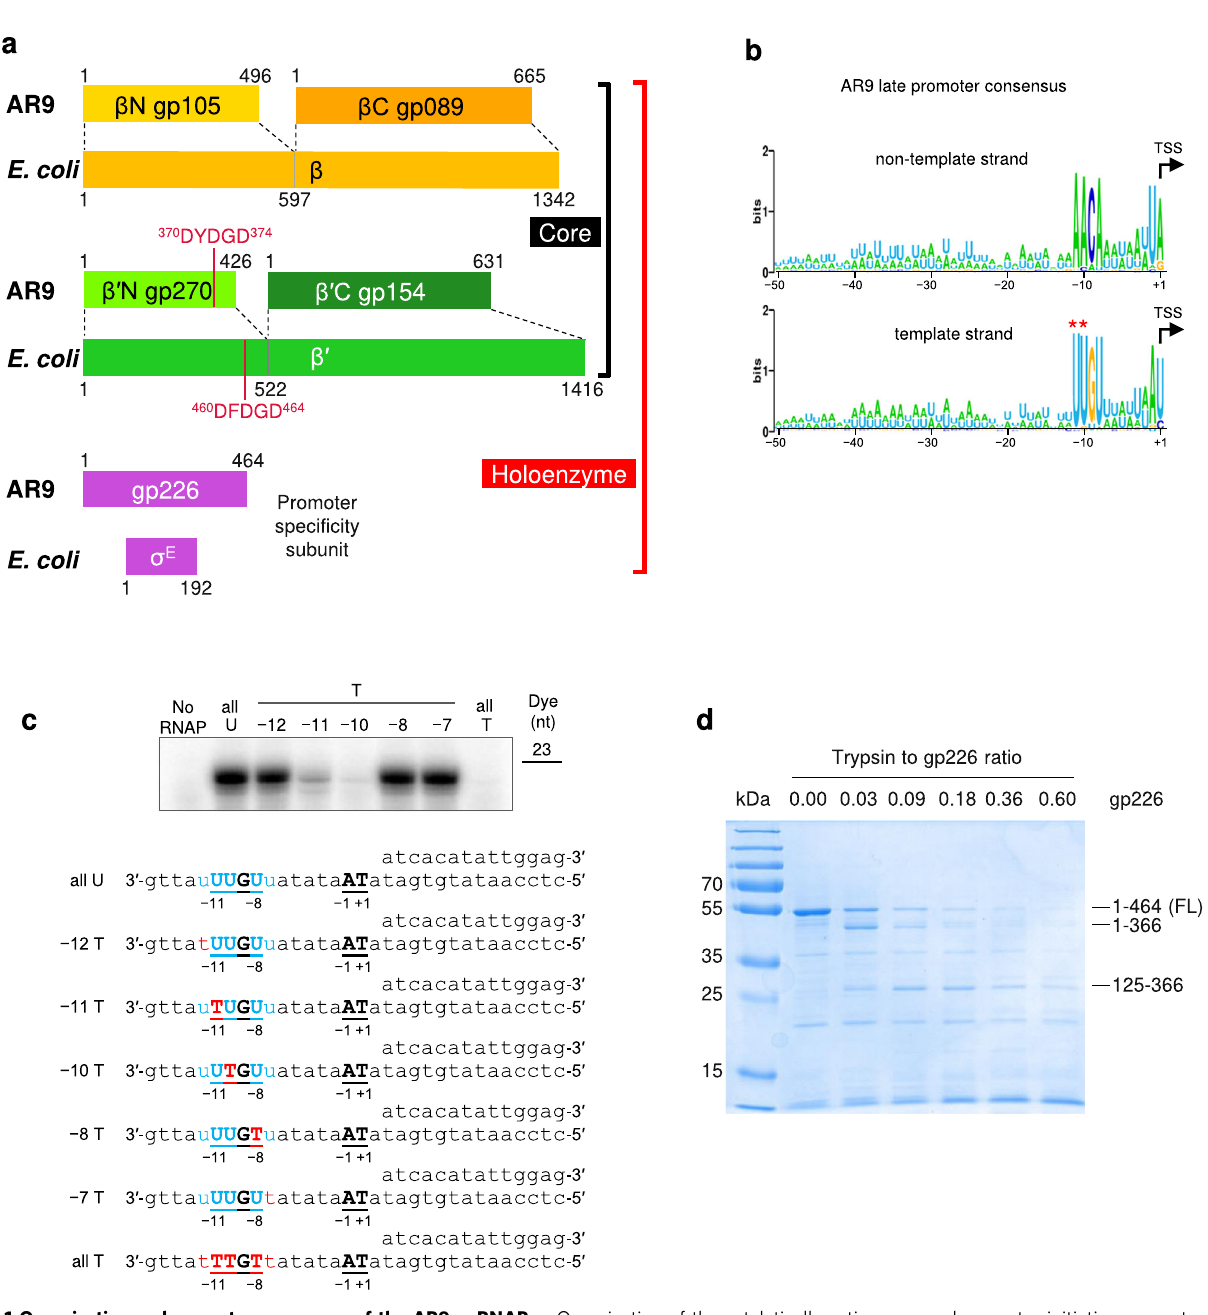
Fig. 1 Organization and promoter consensus of the AR9 nvRNAP. a Organization of the catalytically active core and promoter initiation-competent holoenzyme of the AR9 nvRNAP. A pair of genes encode a protein complex that is homologous to the bacterial subunits β or β ′ . The promoter speci fi city subunit displays no detectable sequence similarity to bacterial sigma factors. b The consensus of AR9 late promoters recognized by the nvRNAP. Both DNA strands are shown. c The dependence of the AR9 nvRNAP in vitro transcription activity on the position and number of T bases in the promoter, which is located in the template strand of DNA (bold-underlined). d The resistance of recombinantly expressed gp226 to proteolysis by trypsin. The identities and sizes of labeled major products, given as residue ranges, have been established using mass spectrometry. FL stands for the full-length protein. Two technical replicates of two biological replicates of the in vitro transcription and trypsin proteolysis experiments resulted in similar outcomes and one of them is shown. The uncropped autoradiograph and SDS PAGE are presented in Supplementary Fig. 1 and Supplementary Data a result, the AR9 nvRNAP claw is smaller and has a boxier appearance than that of its cellular counterparts. In bacterial enzymes, the α subunit dimer serves as a platform for the assembly of the β and β ′ subunits 12 . In the AR9 nvRNAP structure, the split site of the β ′ subunit is spatially close to the putative β ′ - α II interface (Fig. 3), which suggests that this location likely represents a critical point for the formation of tertiary and quaternary structure.